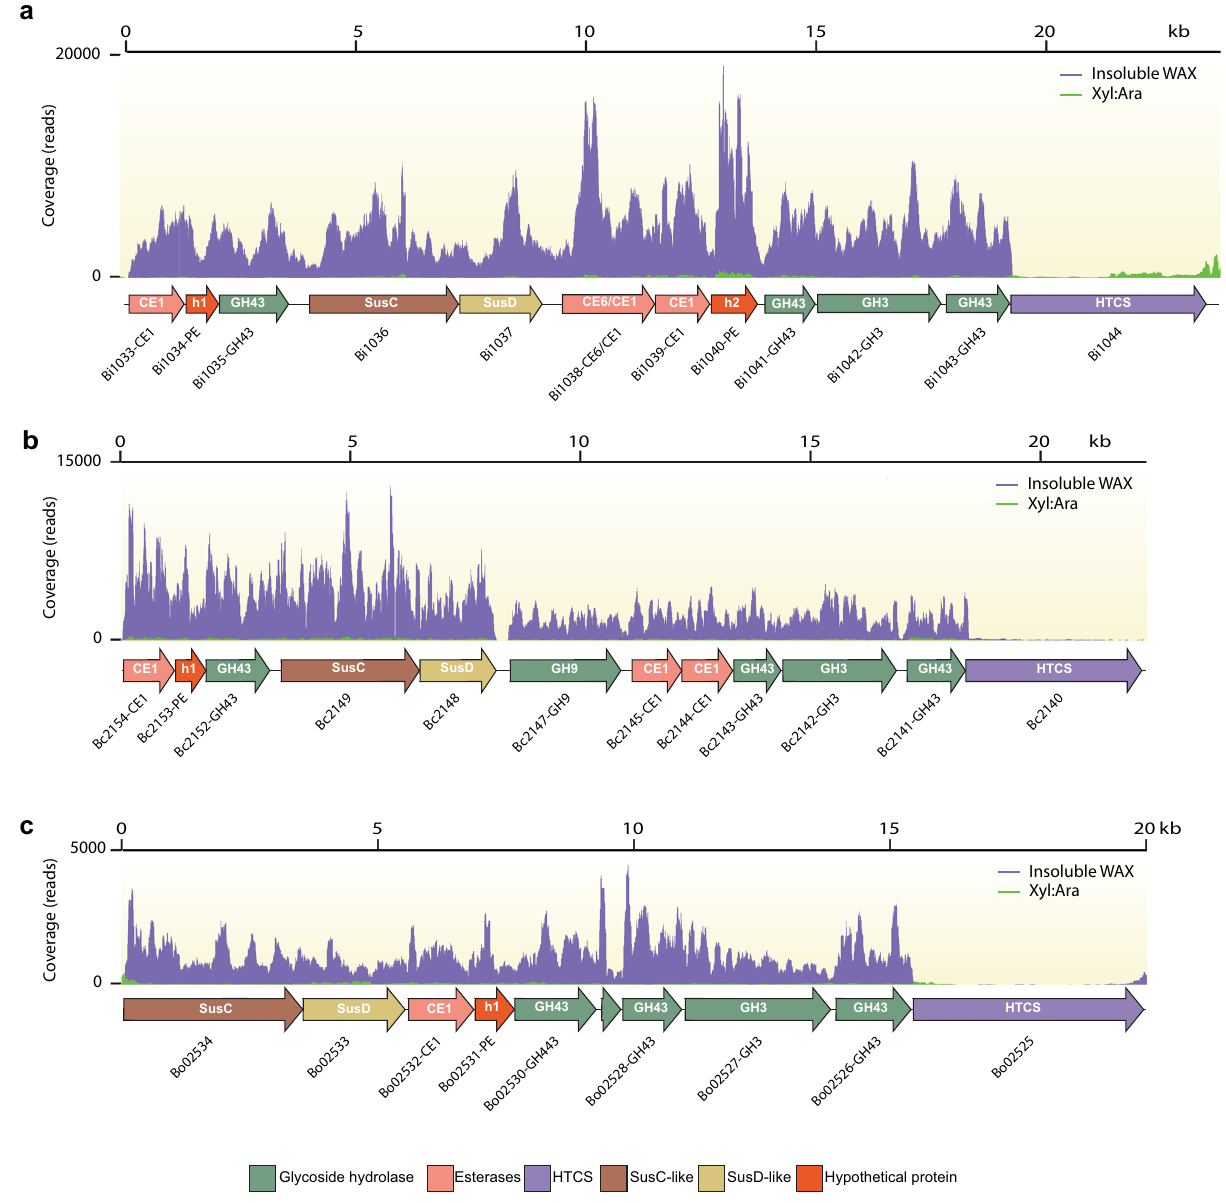
Fig. 2 Comparative transcriptomics analysis of Bacteroides spp grown on insoluble wheat arabinoxylan (InWAX) and a xylose/arabinose mixture (Xyl: Ara). Transcriptome map showing RNASeq coverage of the esterase genes-enriched (EGE) polysaccharide-utilization loci (PUL) during growth on insoluble wheat arabinoxylan (InWAX, purple) compared to growth on the component sugars (Xyl:Ara, green) by ( a ), B. intestinalis ( b ), B. cellulosilyticus , and ( c ), B. oleiciplenus . The genes in the PULs are color coded based on their predicted functions: glycoside hydrolase (GH, green), carbohydrate esterase (CE, salmon), Hybrid Two-Component System (HTCS, purple), Starch Utilization System proteins (SusC/SusD, brown and yellow) and hypothetical proteins (red). RNAseq experiments involved two biological replicates per species and representative traces are shown for each bacterium in the fi gure. For the name Sus or Starch utilization system, note that although this name originally derives from the fi rst functionally characterized homolog or prototypic system, this name is still maintained for these proteins although it is known that similar systems transport different polysaccharides, including xylan, pectin, mannan, and